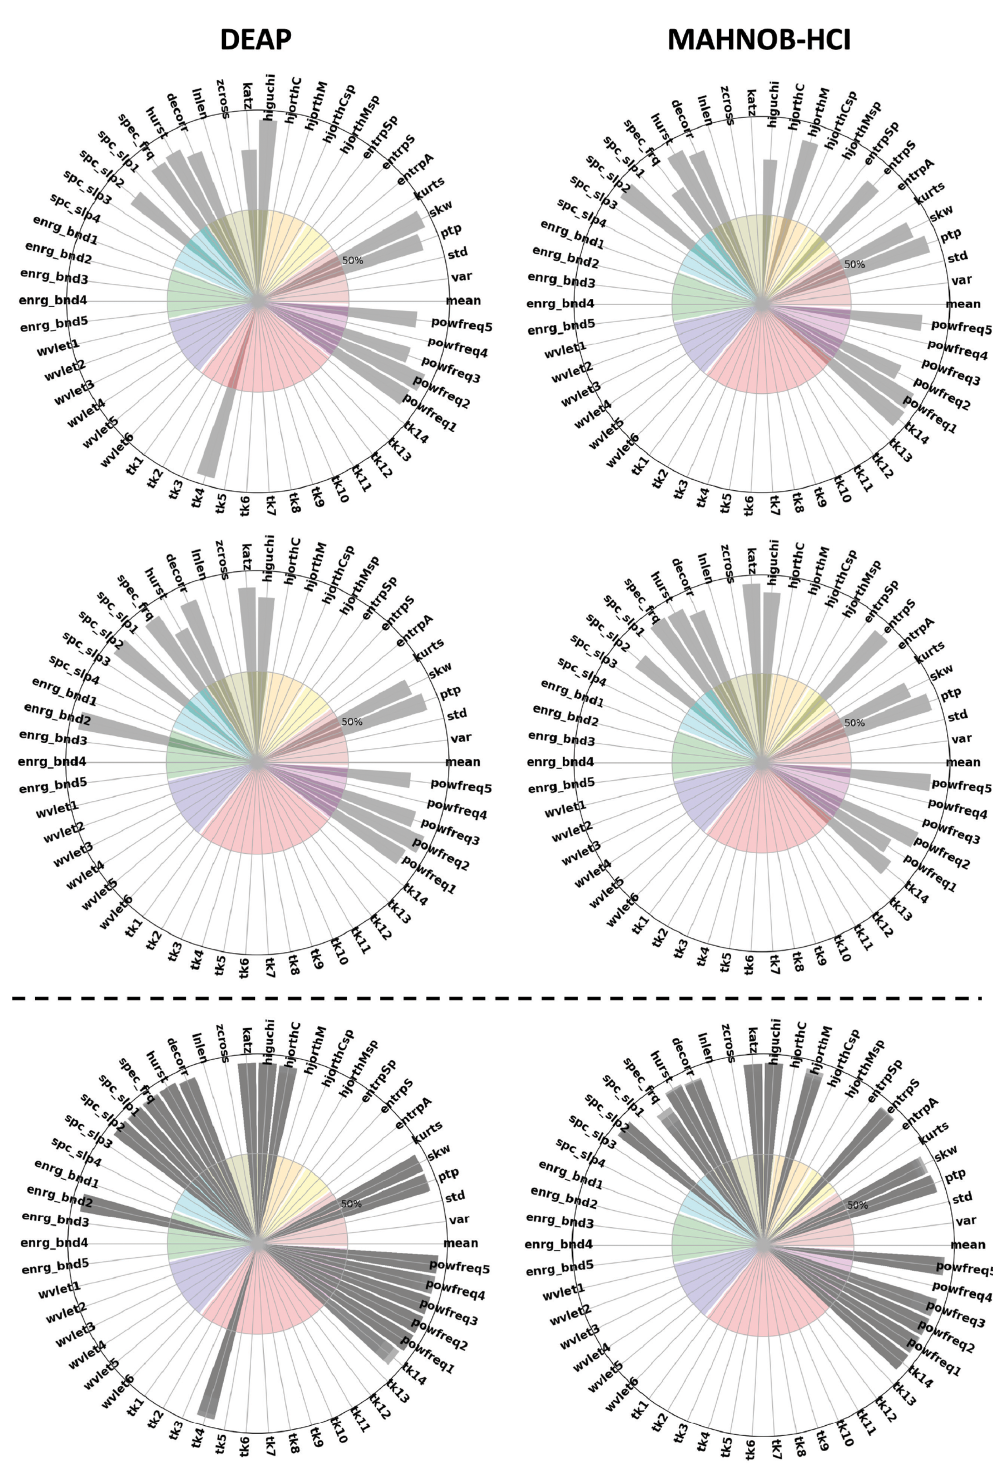
Fig 3. Frequently selected features based on the proposed framework in DEAP and MAHNOB-HCI (DREAMER’s was excluded for better resolution). The colors of the inner circle represent groups of feature extraction methods (statistical, entropy, Hjorth, power spectrum band and energy, Wavelet coefficients and Teager-Kaiser energy). Columns represent how many times a specific feature was selected in an experiment. Below the dashed line is the feature selection frequency across stimuli (i.e. intensity of grey indicates that feature is highly